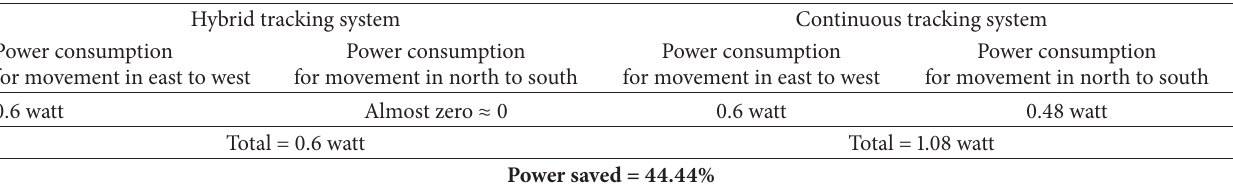
Table 4: Comparison of stepper motor power